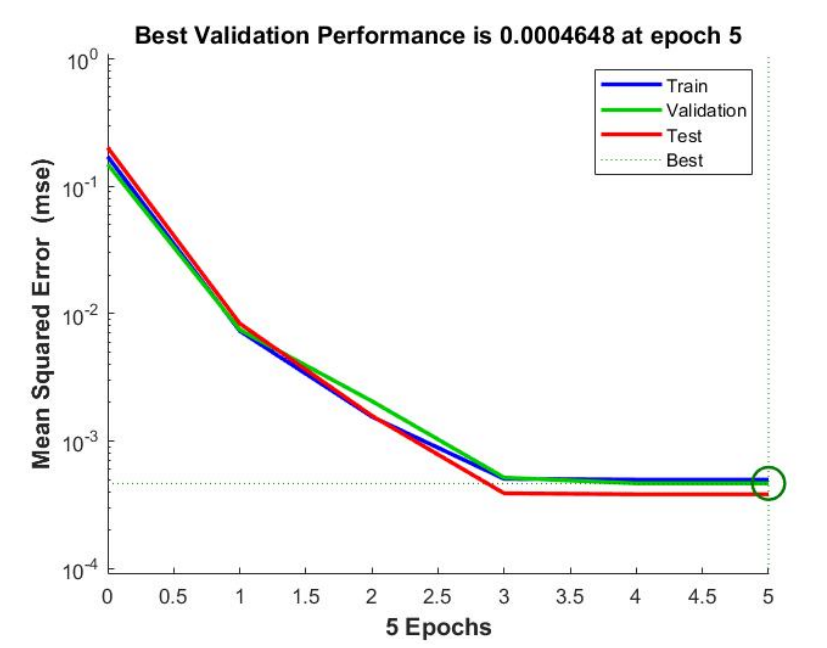
Figure 15. MSE errors in the train, validate, and test data.